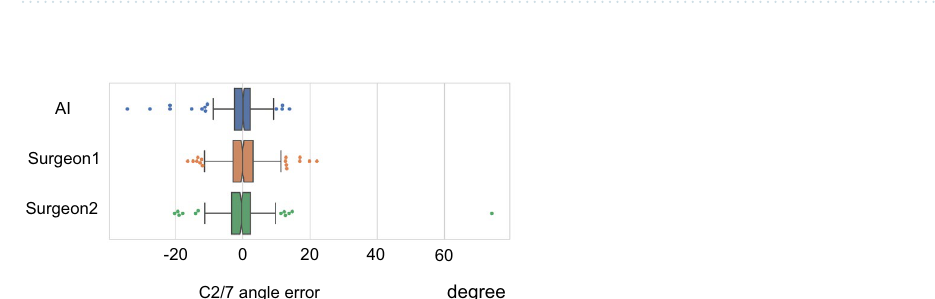
Table 3. Confusion matrix showing AI’s ability to determine the positions when x-rays were taken. AI, artificial intelligence.